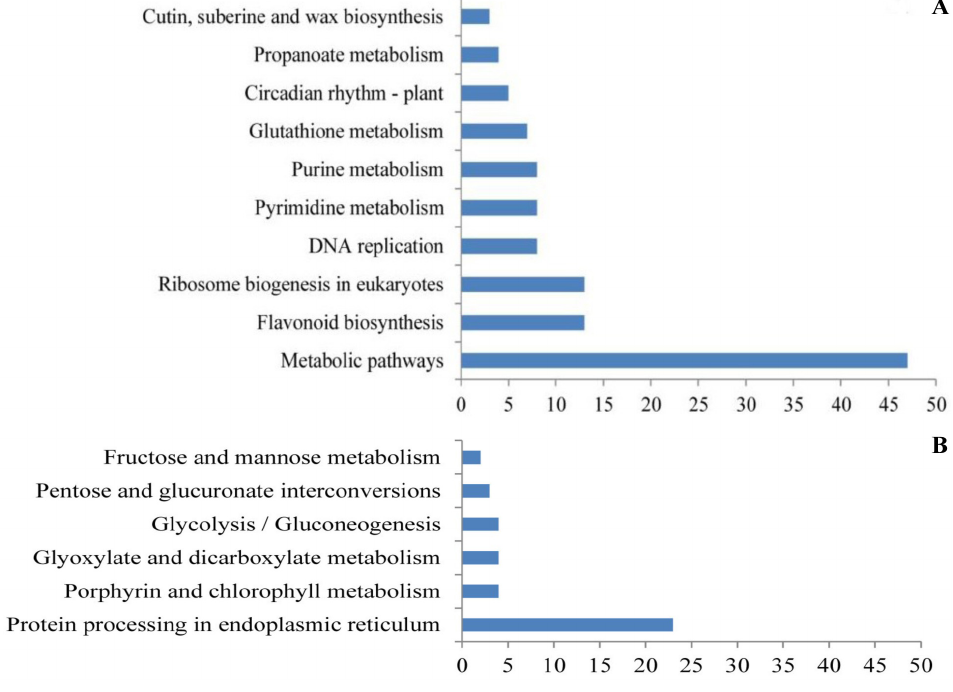
Figure 5. KEGG pathway assignments for ( A ) 320 up-regulated and 275 ( B ) down-regulated DEGs between high-growth allotriploid Populus progeny genotypes (PMR-H) and their diploid parents ( p- values <